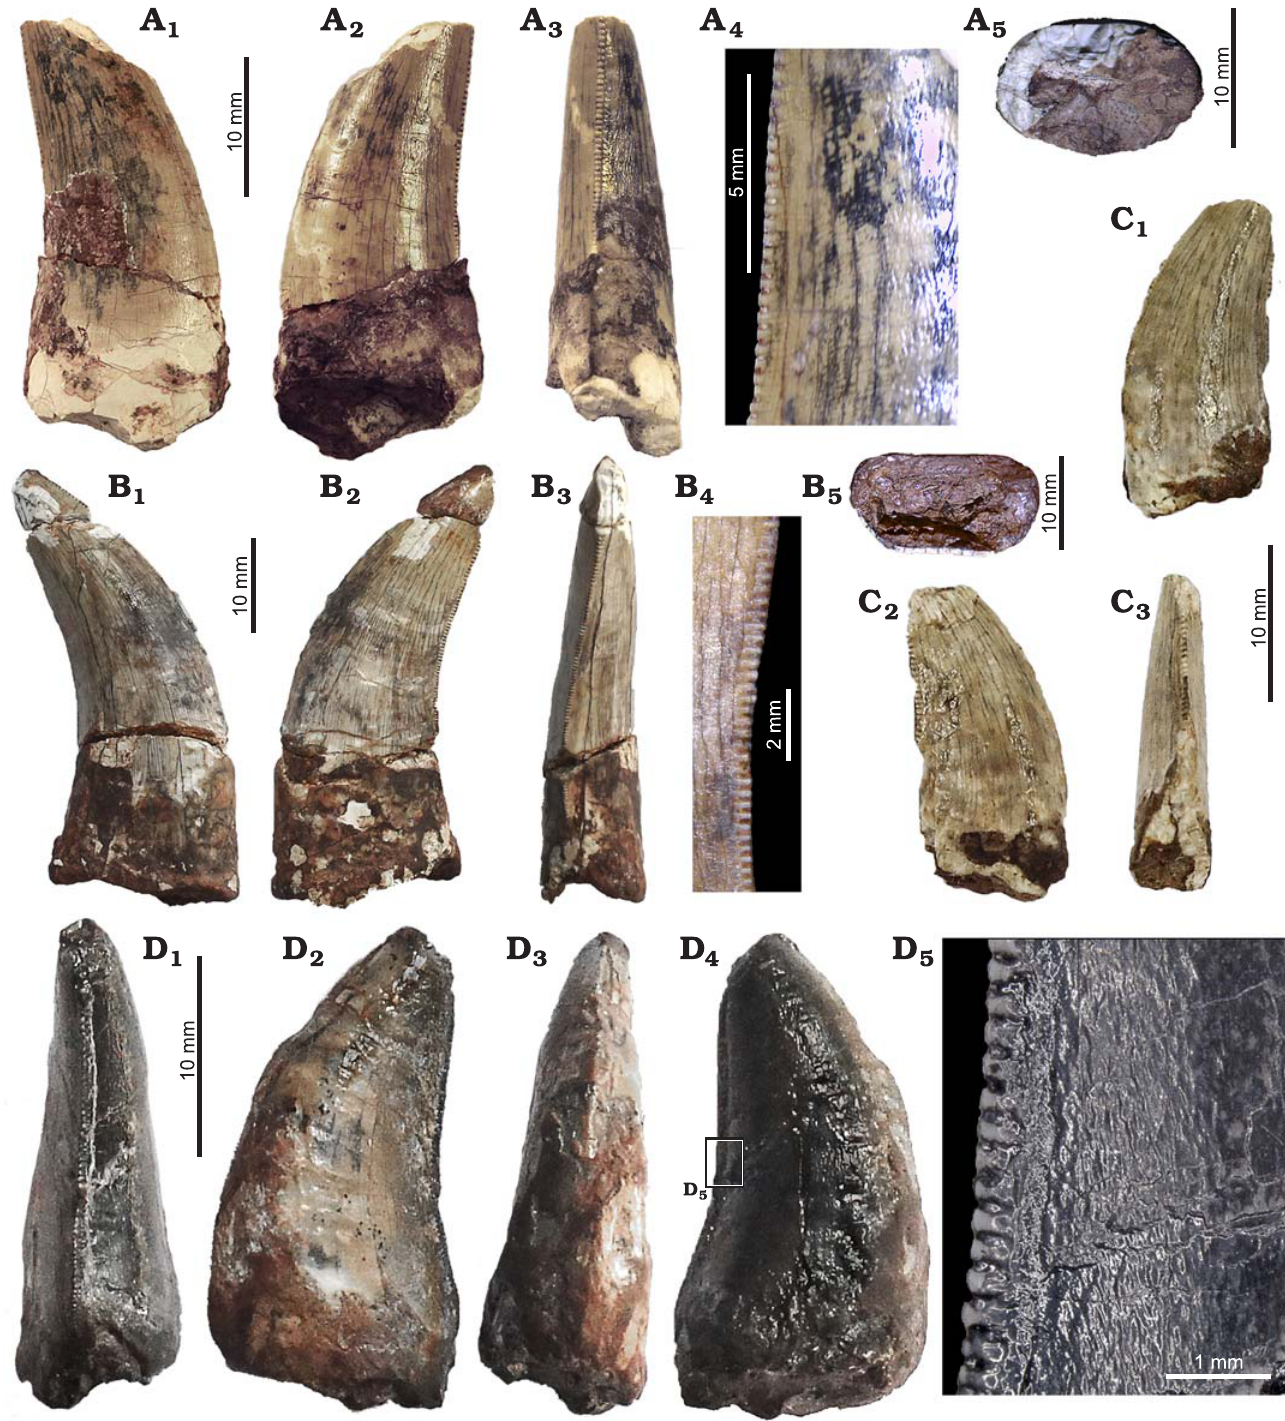
Fig. 1. Theropod teeth from the Middle Jurassic Tegama Group, Agadez, Niger. A . MUPE HB-142 in labial (A 1 ), lingual (A 2 ), distal (A 3 ), and basal (A 5 ) views, close-up (A 4 ). B . MUPE HB-118 in lateral (B 1 , B 2 ), distal (B 3 ), and basal (B 5 ) views, close-up (B 4 ). C . MUPE HB-125 in lateral (C 1 , C 2 ) and distal (C 3 ) views. D . Spinosaurid tooth, MUPE HB-87 in distal (D 1 ), lingual (D 2 ), mesial (D 3 ), and labial (D 4 ) views; close-up view of the labial side (D 5 ); note the deeply veined enamel surface texture and the shape and size of the distal